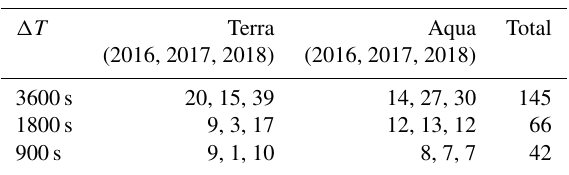
Table 2. Number of cloud profiles during ORACLES deployments with a co-located MODIS Terra or Aqua retrieval for (cid:49)T less than 3600, 1800, or 900s.